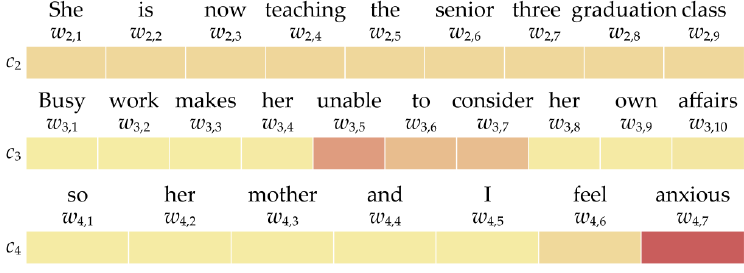
Figure 4. Visualization of word-clause attention.